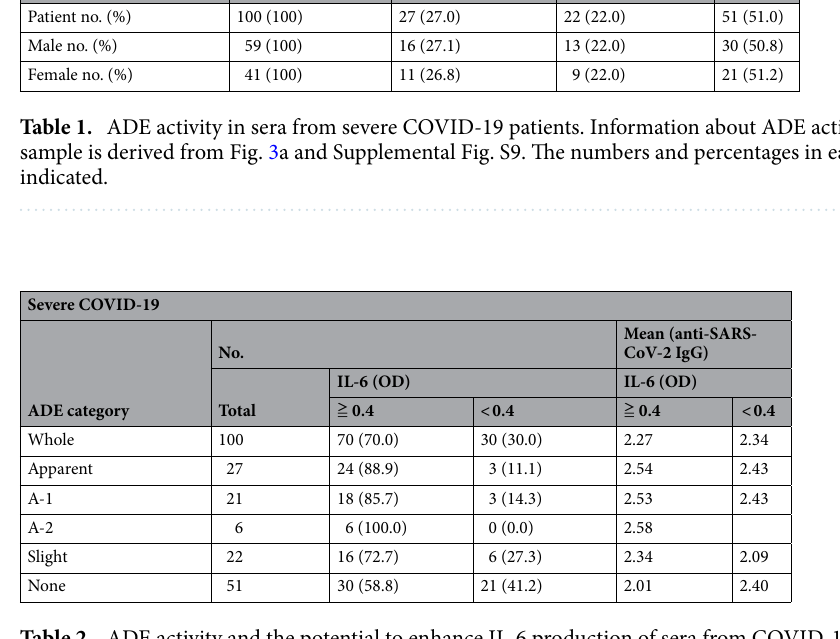
Table 2. ADE activity and the potential to enhance IL-6 production of sera from COVID-19 patients. Based on the results from Fig. 3a and Supplemental Figs. S9 and S13, each serum sample from COVID-19 patients (N = 100) was divided into several groups as shown. More than 0.4 of the top OD value in the ELISA assay was regarded as positive activity to enhance IL-6 production. The number in parentheses means the percentage in each ADE